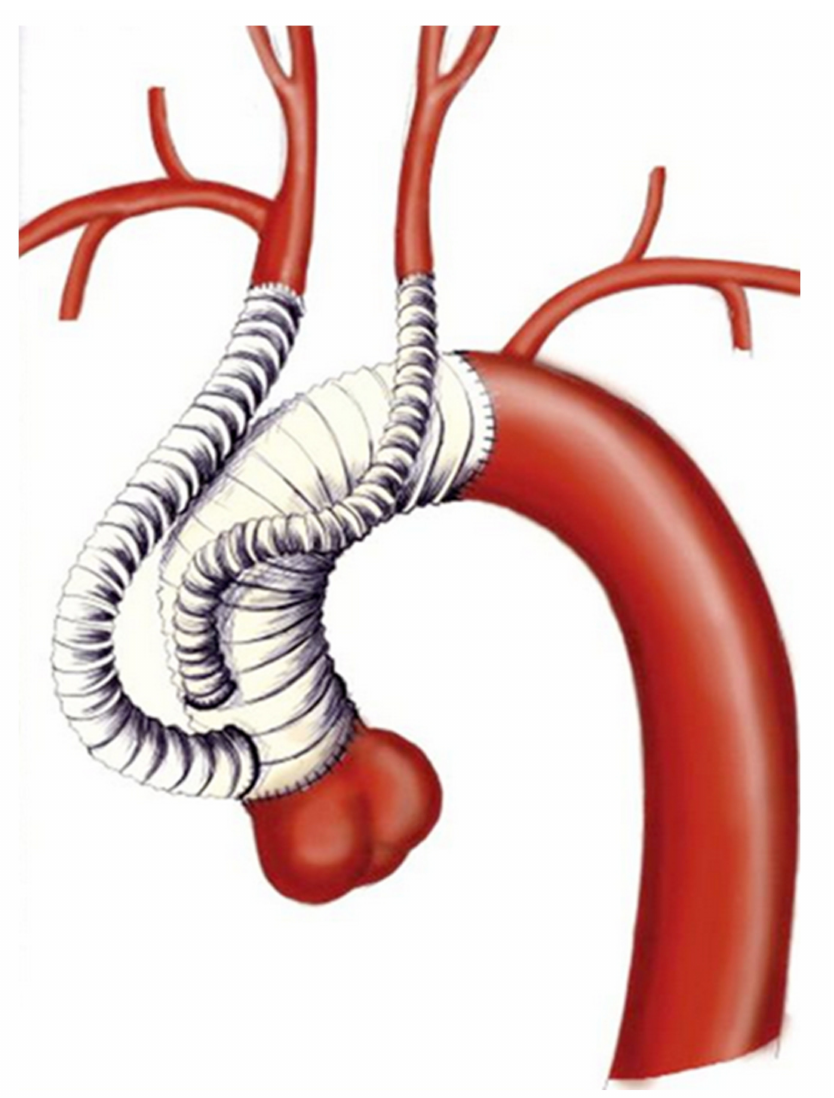
Figure 3. Schematic illustration of Type II Hybrid